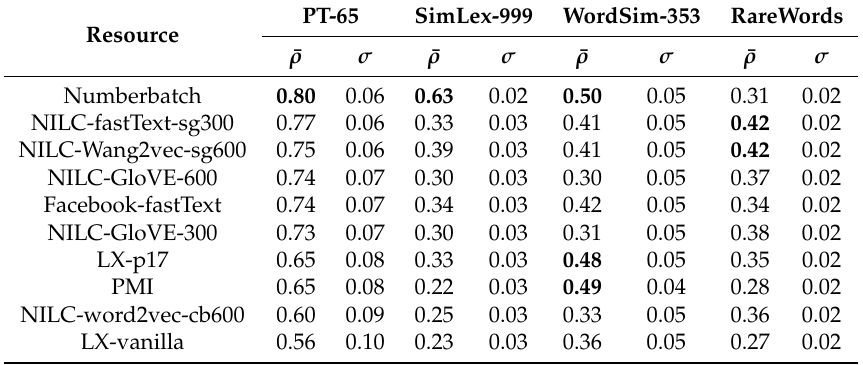
Table 12. Spearman correlation ( ρ ) for the distributional approaches in the different